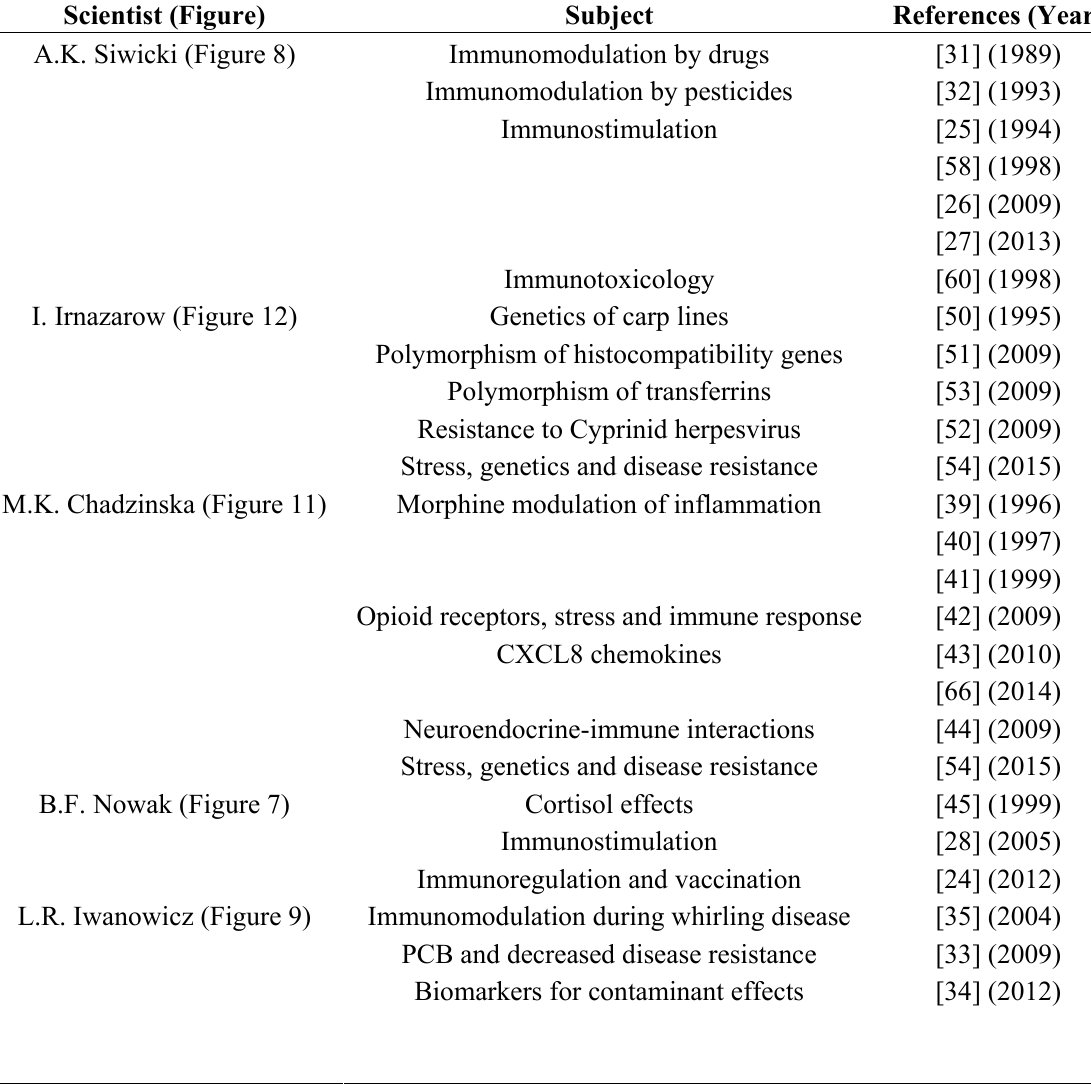
Table 2. Polish scientists in the field of fish immunology starting their career between 1985 and 2005 a